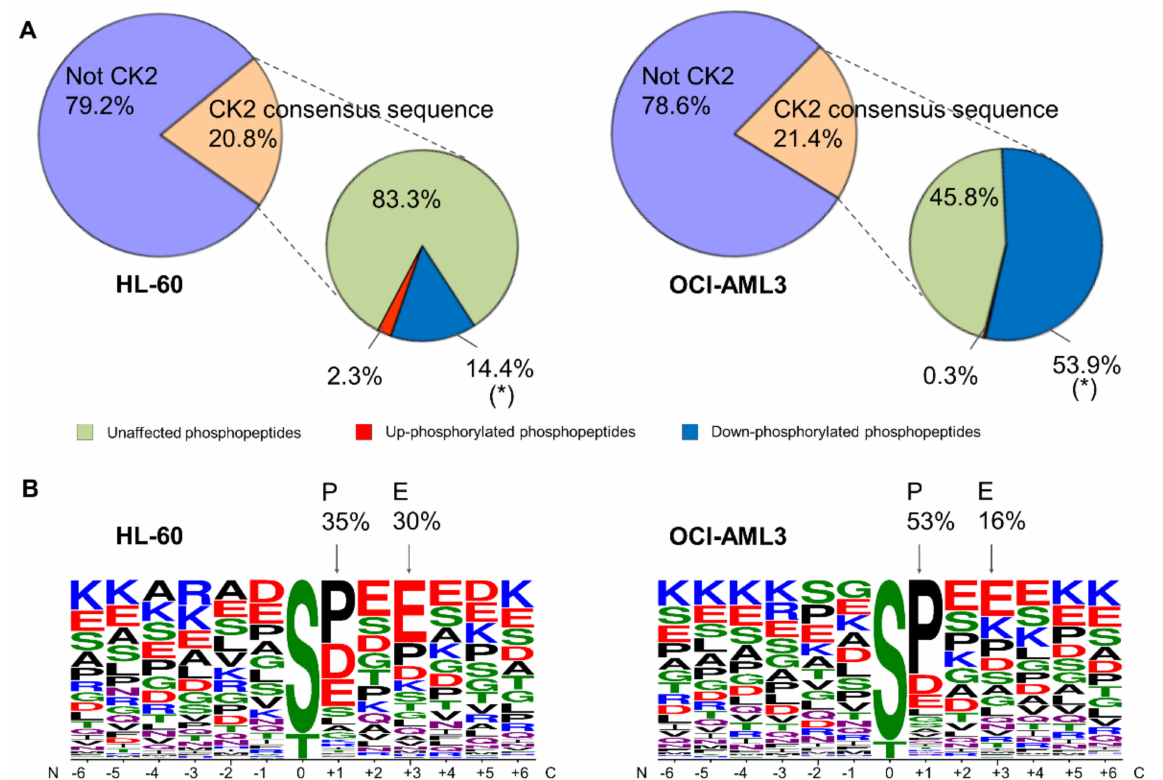
Figure 4. Sequence analysis of phosphopeptides identified in AML cells treated with the CK2 inhibitor CX-4945: ( A ) Pie charts show Table 60. and OCI-AML3 cells that either, contains or not the CK2 consensus sequence. For the former category, the percentage of phosphopeptides that are significantly increased or decreased, or that do not show significant changes in their phosphorylation levels are reported in lateral pie charts; ( B ) Sequence logos corresponding to phosphopeptides significantly down-phosphorylated in AML cells treated with CX-4945. Logos were generated using WebLogo tool and MaxQuant amino acid sequence window as input [38]. (*) Phosphopeptides with decreased phosphorylation due to the reduction of protein abundance were not considered as differentially